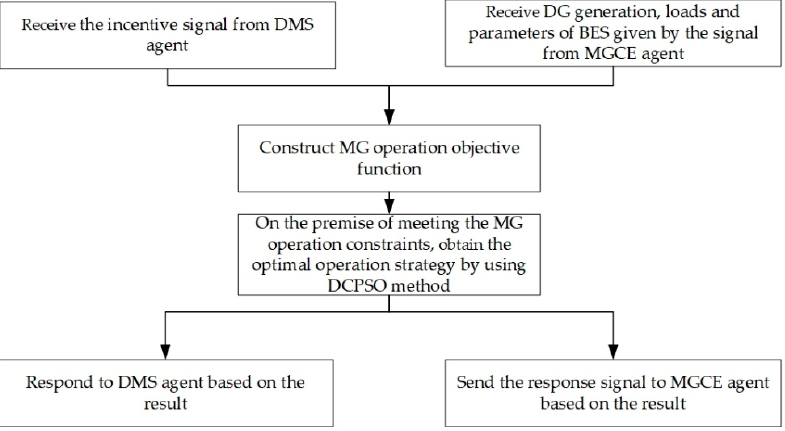
Figure 2. The process of the MGCC layer.